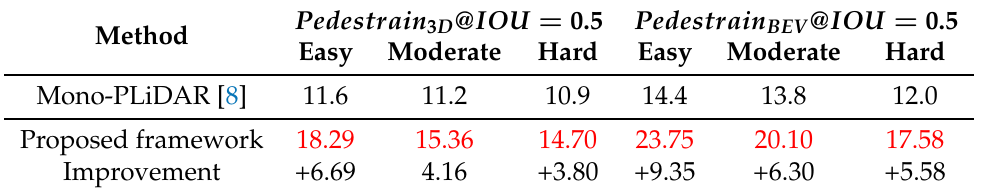
Table 4. Performance of 3D detection of the “pedestrian” category of the KITTI validation subset. We indicate the highest results with red.